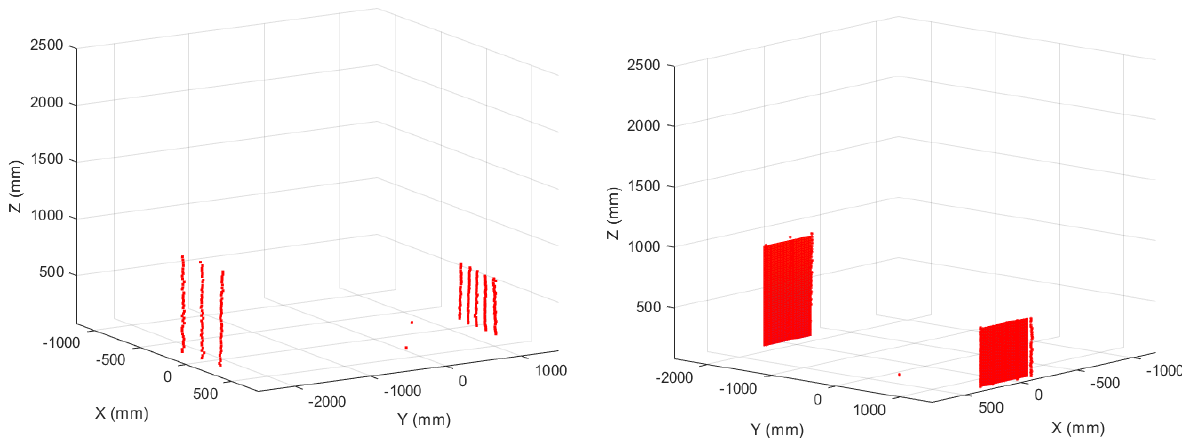
Figure 20. Sample points relative to the two obstacles.